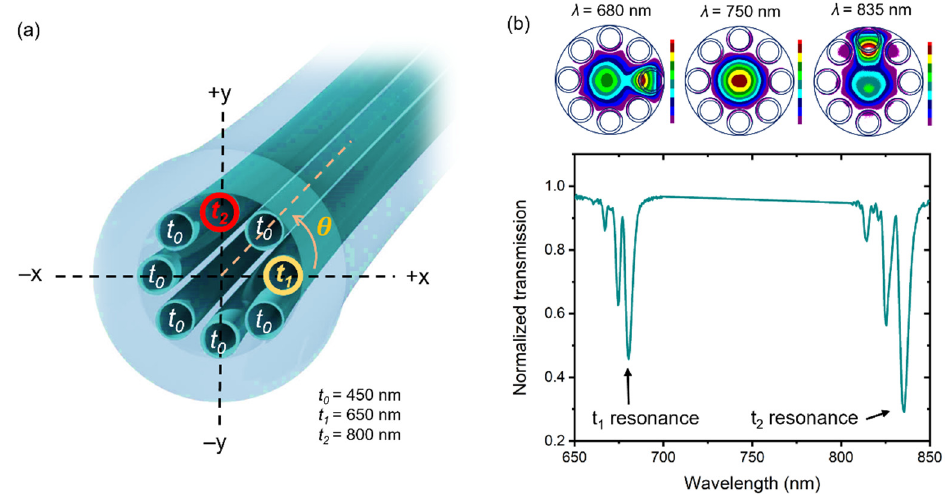
Figure 1. ( a ) HCPCF cross-section diagram ( t 0 , t 1 , and t 2 : thicknesses of the cladding tubes; θ : curvature angle). ( b ) Typical transmission spectrum for a straight fiber and mode profiles at selected wavelengths.